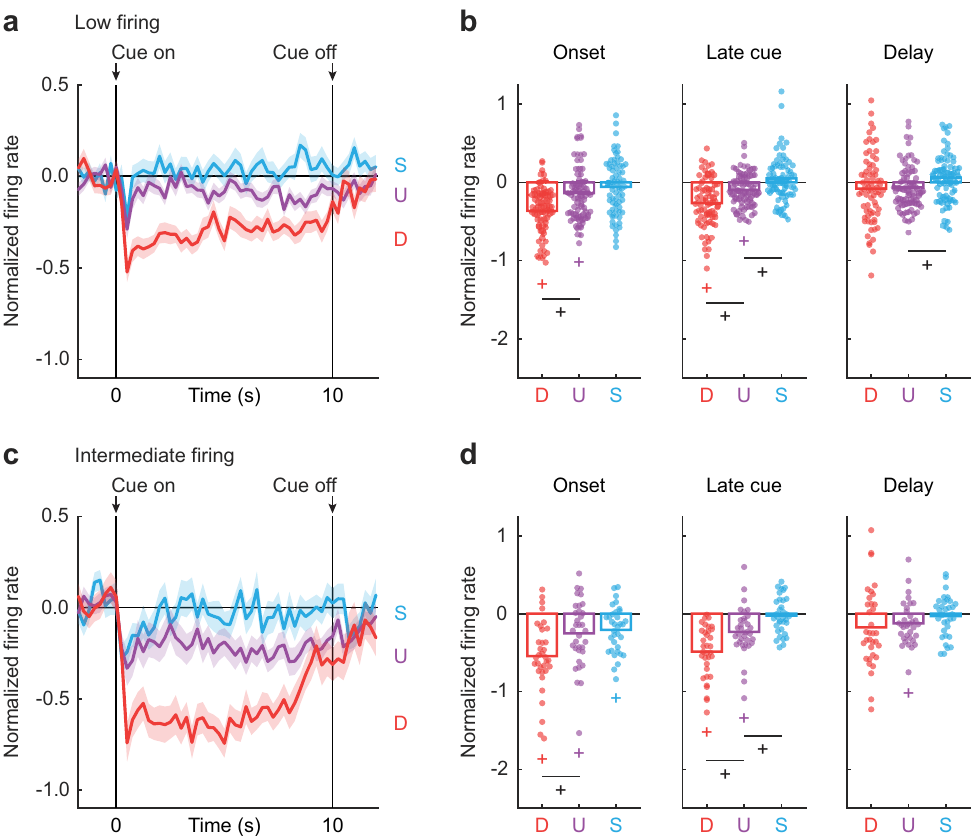
Fig. 3 Low fi ring and Intermediate fi ring neurons preferentially decrease fi ring to threat cues. a Mean ± SEM normalized fi ring rate to danger (D, red), uncertainty (U, purple) and safety (S, blue) is shown from 2 s prior to cue onset to 2 s following cue offset for the Low fi ring neurons ( n = 74). Cue onset and offset are indicated by vertical black lines. SEM is indicated by shading. b Mean (bar) and individual (data points), normalized fi ring rate for Low fi ring neurons during the fi rst 1 s cue interval (onset, left), the last 5 s cue interval (late cue, middle), and 2 s following cue offset (delay, right) are shown for each cue (D, danger, red; U, uncertainty, purple; and S, safety, blue). c Mean ± SEM normalized fi ring rate for the Intermediate fi ring neurons ( n = 34), shown as in a . d Mean (bar) and individual (data points), normalized fi ring rate for Intermediate fi ring neurons, as in b . + 95% bootstrap con fi dence interval for differential cue fi ring does not contain zero. + 95% bootstrap con fi dence interval for normalized fi ring rate does not contain zero (colored plus Fig. 3d, left), and during late cue ( M = − 0.26, 95% CI [ − 0.42, − 0.10]; Fig. 3d, middle). Like for Low fi ring neurons, differential inhibition of fi ring was not observed to uncertainty and safety at cue onset ( M = − 0.05, 95% CI [ − 0.23, 0.14]; Fig. 3d, left), but was observed during late cue ( M = − 0.21, 95% CI [ − 0.34, − 0.05]; Fig. 3d, middle).